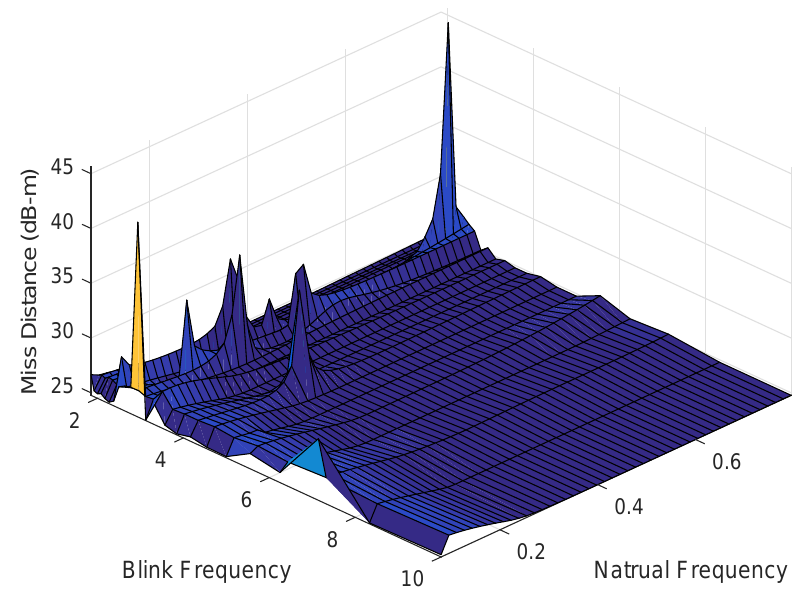
Figure 26. The average miss distance during a set of engagements with varied antenna angle tracking response frequencies and blinking frequencies using a sinusoidal